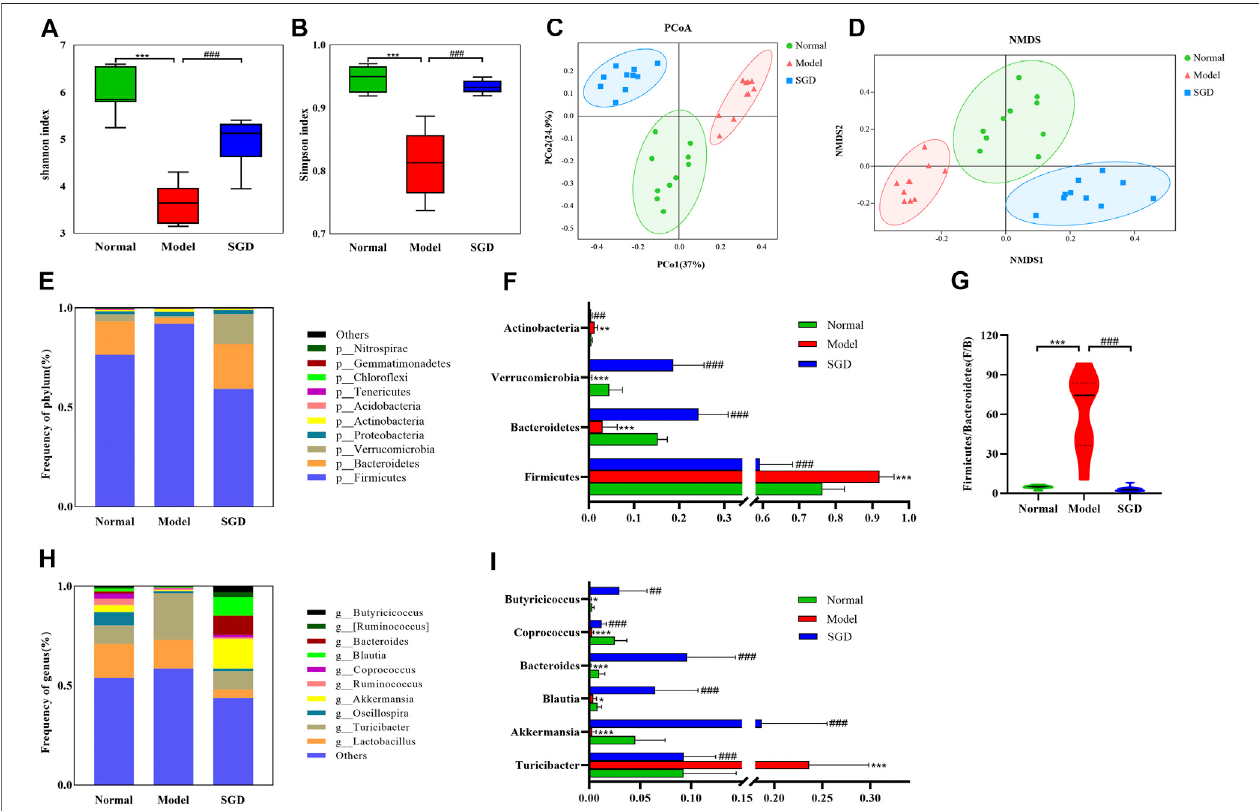
FIGURE3| SGDtreatmentmodulatedthegutmicrobiotacompositioninPCOSrats.Shannon (A) andSimpson (B) diversityindex.PCoA (C) andNMDS (D) plotof intestinal microbiota based on OTU level. (E) Column diagram of community composition at phylum level. (F) The relative abundances of Firmicutes , Bacteroides , Verrucomicrobia , and Actinobacteria. (G) Firmicutes/Bacteroides ratio. (H) Column diagram of community composition at genus level. (I) The relative abundances of Turicibacter , Akkermansia , Blautia , Bacteroides , Coprococcus and Butyricicoccus in three groups.